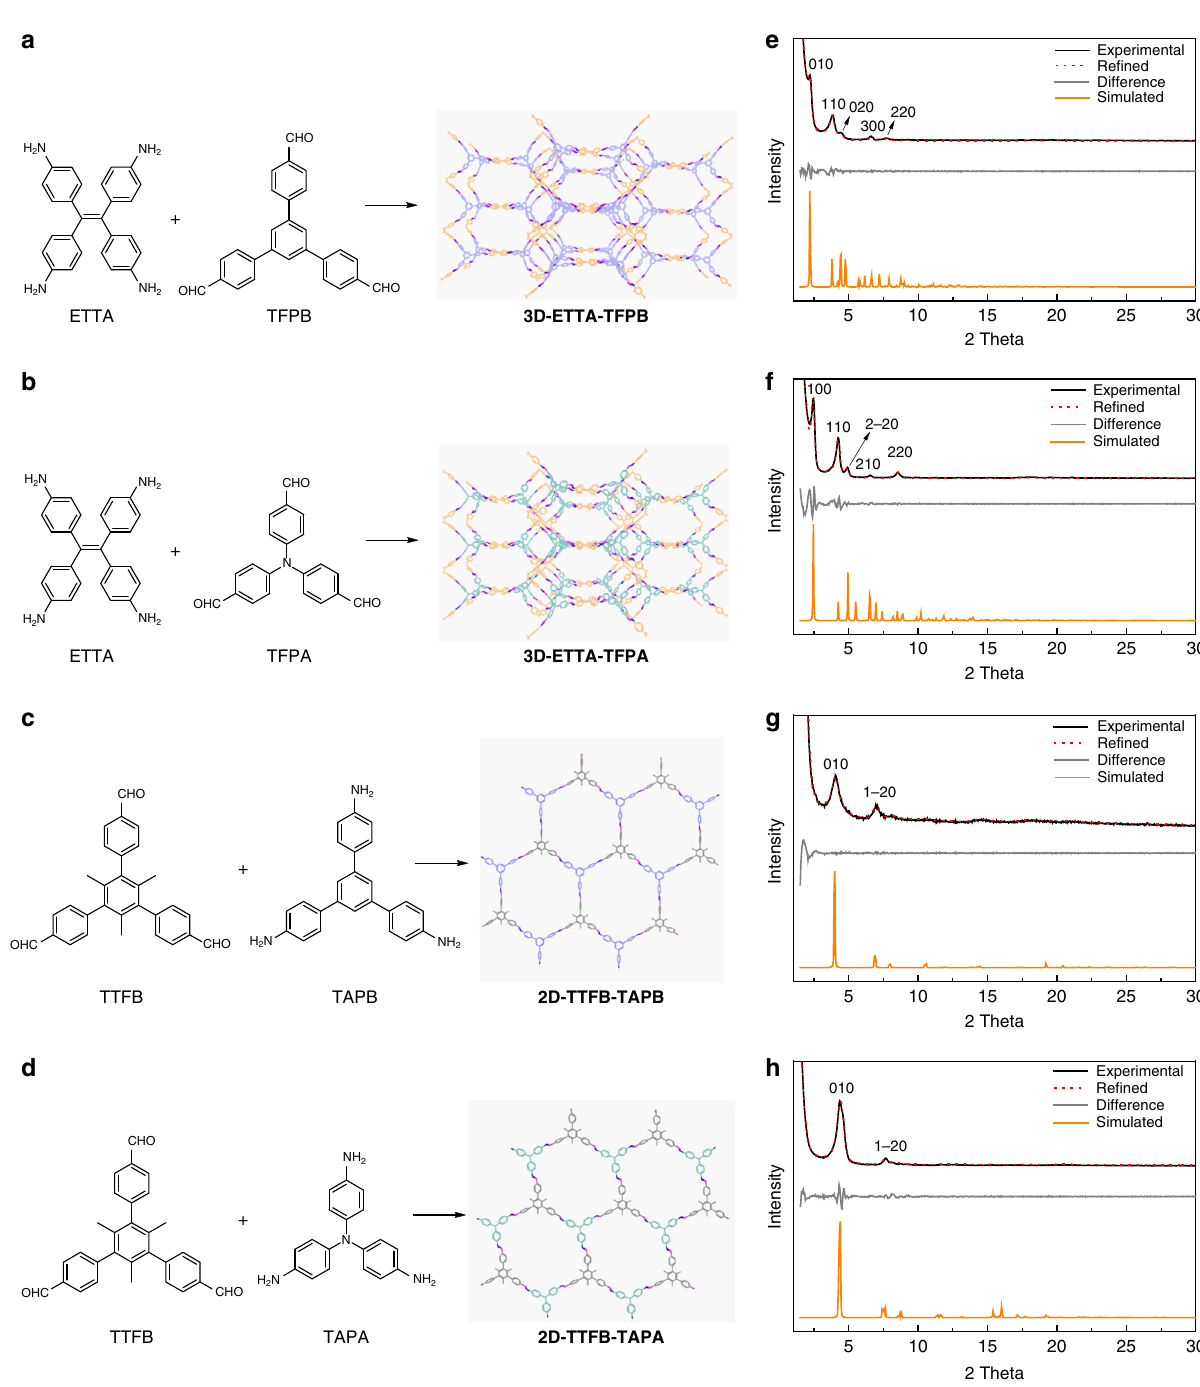
Fig. 4 Targeted synthesis of the designed COFs. a – d The monomers used to synthesize the two 3D-COFs ( a , b ) and the two 2D-COFs ( c , d ) and their structures. e – h Comparison of the simulated and experimental PXRD patterns for the 3D-COFs ( e , f ) and the eclipsed 2D-COFs ( g , h calculated based on the N 2 adsorption data in the range of P/P 0 between 0.05 and 0.2 (Supplementary Fig. 21). For the 3D-COFs, pore volume (at P / P 0 = 0.99) and pore size to be 1526 and 2448 surface areas of 1174 and 1202 m 2 g -1 were estimated for 3D- m 2 g -1 , 1.38 and 1.56 cm 3 g − 1 , and 2.05 and 1.48 nm for 2D- ETTA-TFPB and 3D-ETTA-TFPA , respectively, with total pore TTFB-TAPB and 2D-TTFB-TAPA , respectively (Supplementary volumes (at P / P 0 = 0.99) being 0.75 cm 3 g − 1 for the former and Fig. 20c, d). The observed pore sizes well match the theoretically predicted ones. 0.77 cm 3 g − 1 for the latter. Their pore size distributions (PSDs) (NLDFT), which display main distributions around 1.73 and 1.49 nm for 3D-ETTA-TFPB and 3D-ETTA-TFPA , respectively, indicating a good degree of crystallinity (Fig. 5c, d). In the case of